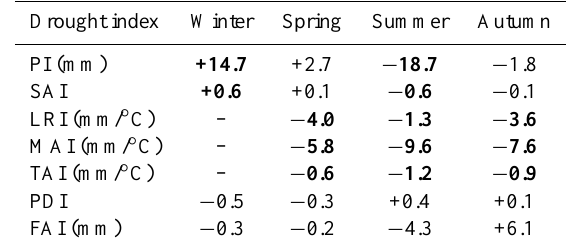
Table 1. Spatial average of projected seasonal change of drought in- dices by 2071–2100 considering A1B scenario taking into account the 229 grid points located within Hungary (reference period: 1961– 1990). Statistically significant projected changes at 0.05 level are indicated by bold characters. LRI, MAI, and TAI are not relevant for winter because of possible negative temperature values.